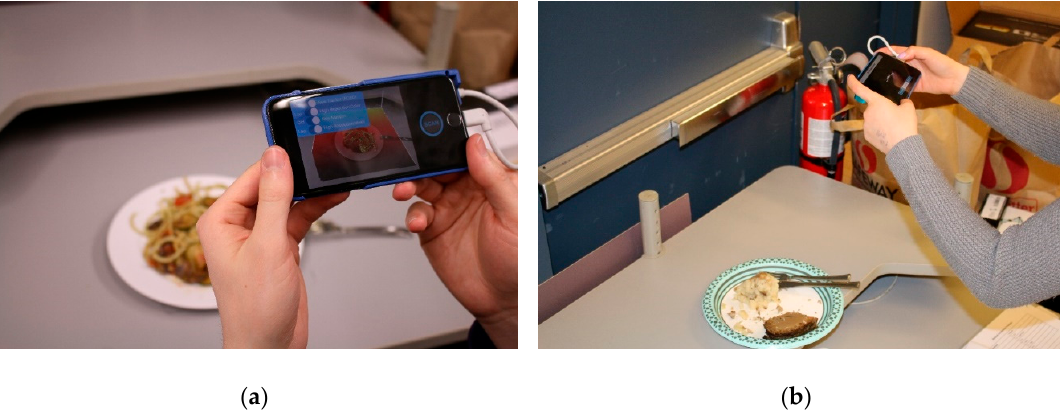
Figure 12. Participants using the DietSensor system during the comprehensive system testing with the prepared food. ( a ) A participant using DietSensor before eating, of Plate 2 with mixed food items, and ( b ) a participant scanning the leftovers of Plate 3 with food items separate.